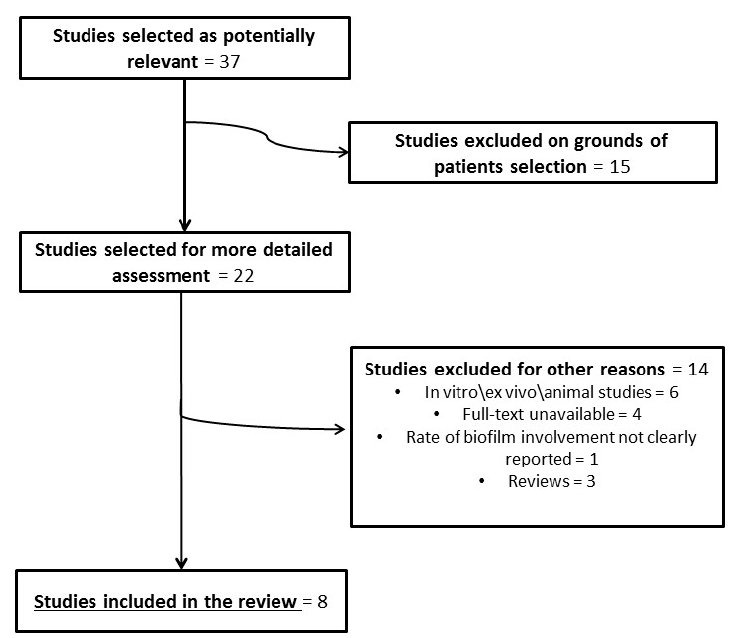
Figure 1. Flowchart of article selection (biofilms in chronic adenoiditis).